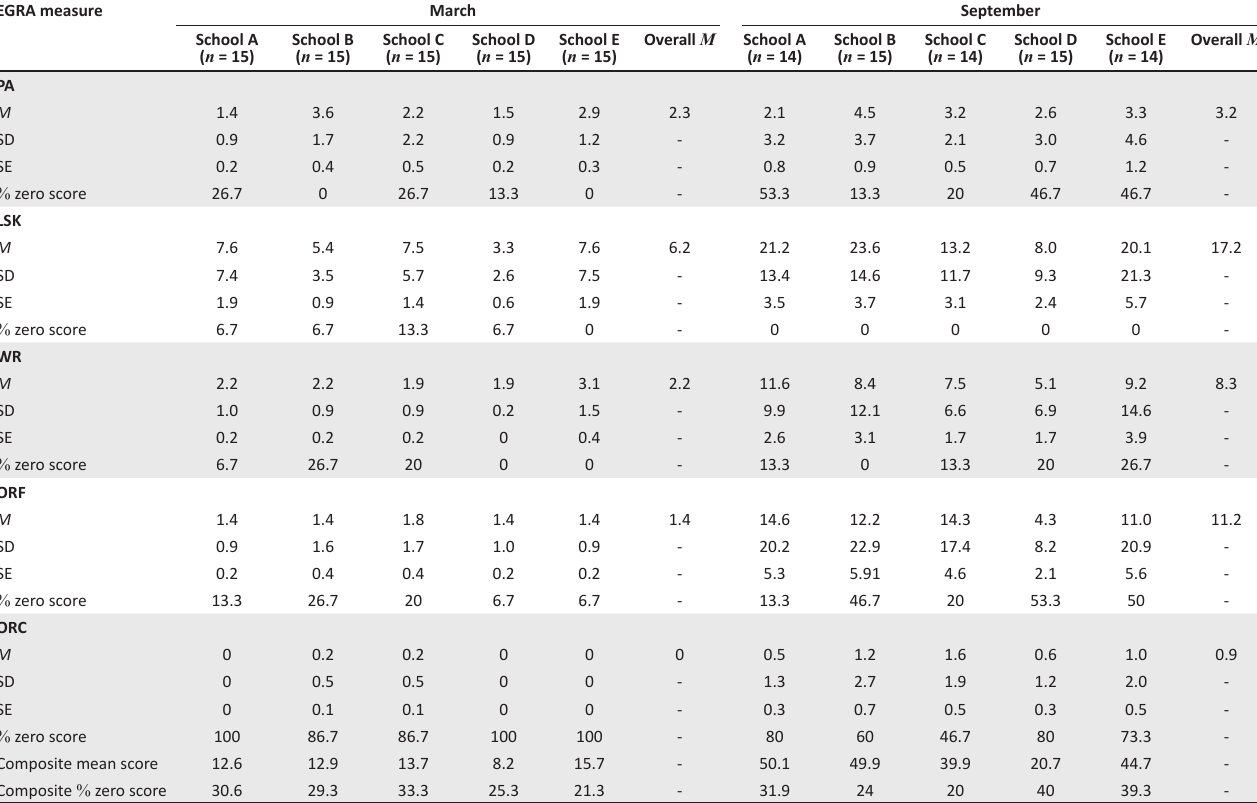
TABLE 3: Performance on reading measures per school. EGRA